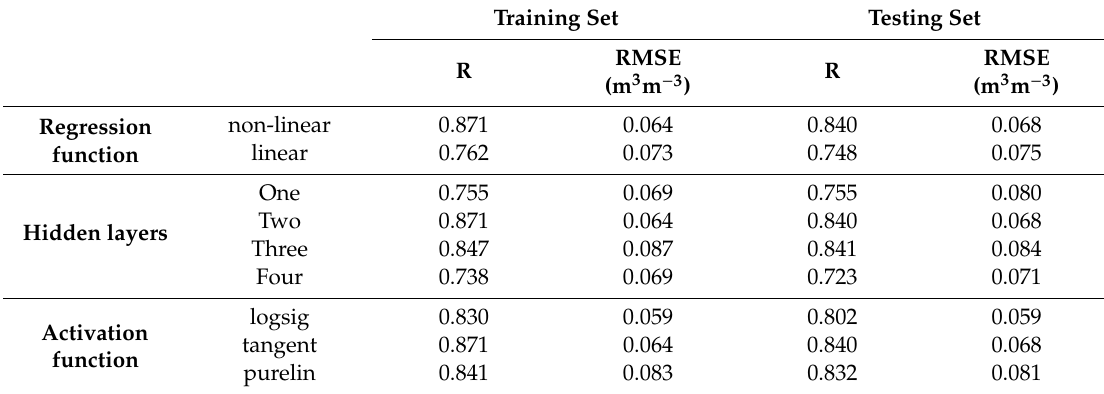
Table 5. Accuracy assessment of the BP-ANN